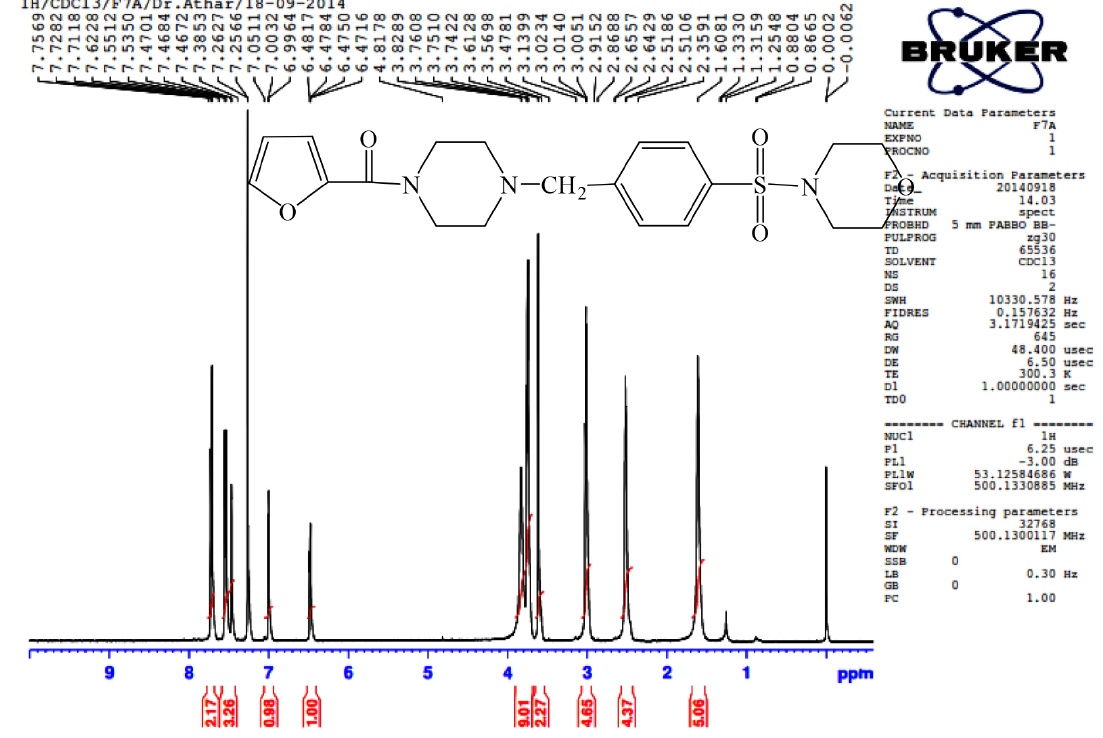
FIGURE 7 - 1 H-NMR spectrum of -furyl{4-[4-(4-morpholinylsulfonyl)benzyl]-1-piperazinyl}methanone ( 5a